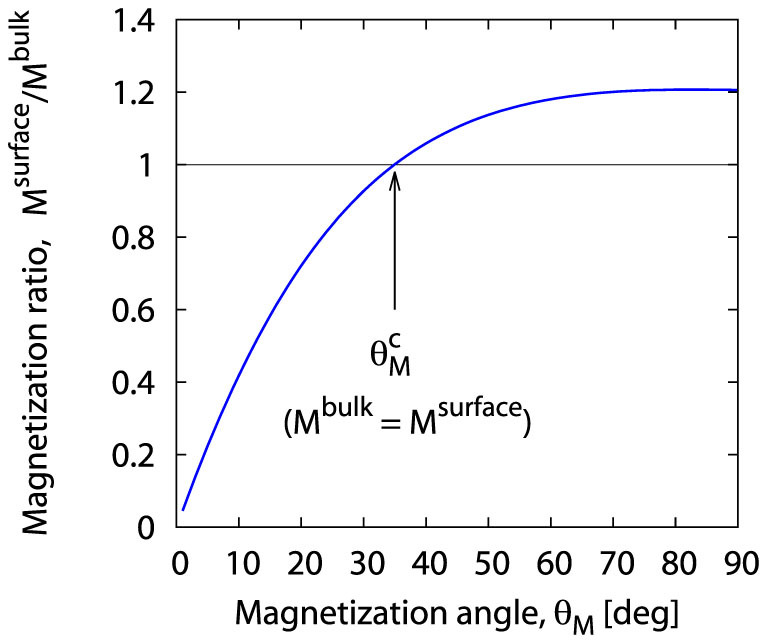
Magnetization angle dependence of the magnetization ratio resulting from our model of surface pinning in (Ga,Mn)As thin films (see Eq. 43); Msurface and Mbulk denote the surface and bulk magnetization, respectively;  is the SWR critical angle.